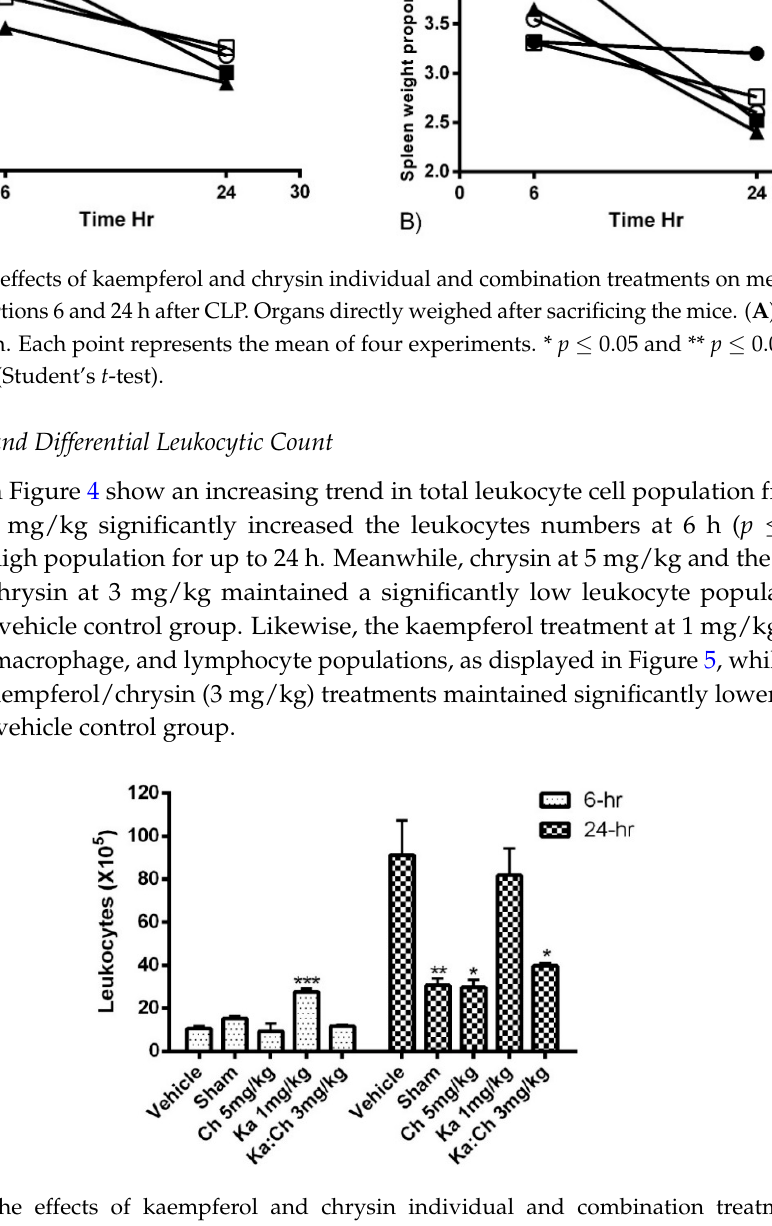
Figure 4. The effects of kaempferol and chrysin individual and combination treatments on intraperitoneal fluid (IPF) total white blood cell (WBC) count. Mice were i.p. injected with treatments or vehicle 1 h prior to CLP and sacrificed at 6 and 24 h time points. IPF was screened with trypan blue for total WBC count. * p ≤ 0.05, ** p ≤ 0.01, and *** p ≤ 0.001 versus CLP/vehicle (Student’s t -test).